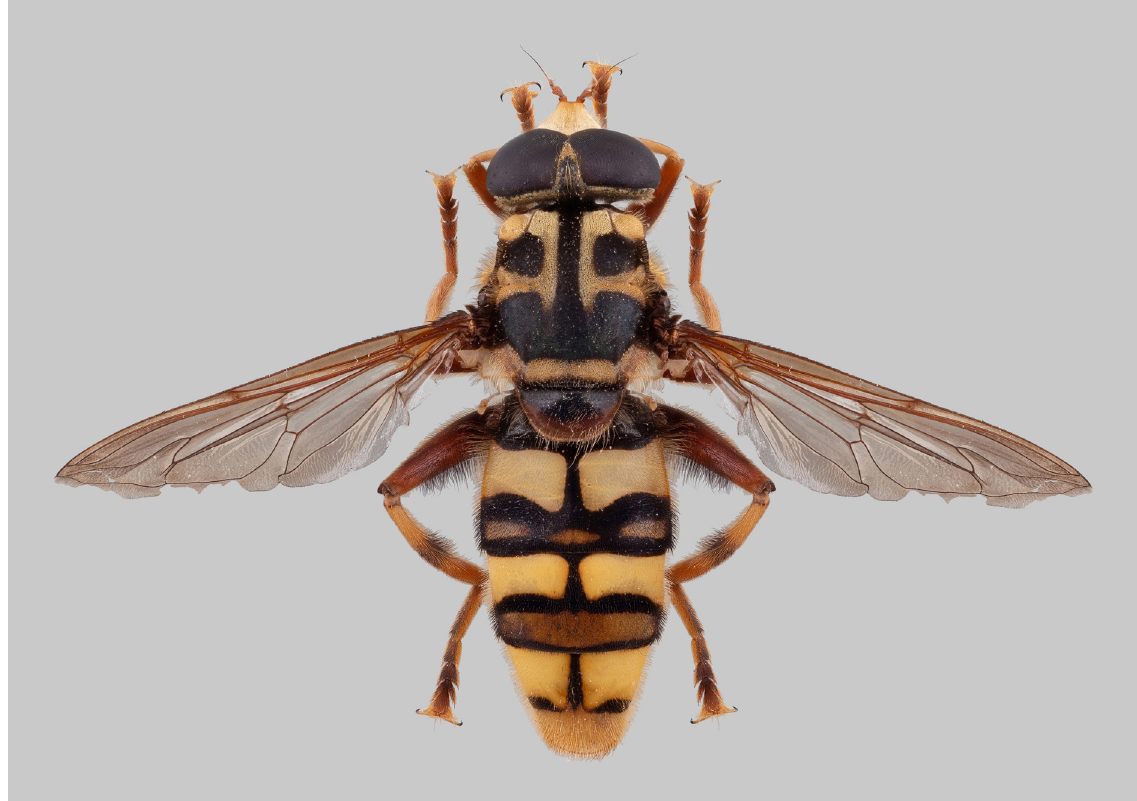
Fig. 2. Milesia cretica Bot & van Steenis sp. nov. ♂, (SBH), habitus dorsal. Collected on Crete, Imbros Gorge, 17 October 2017, leg. and coll. S.